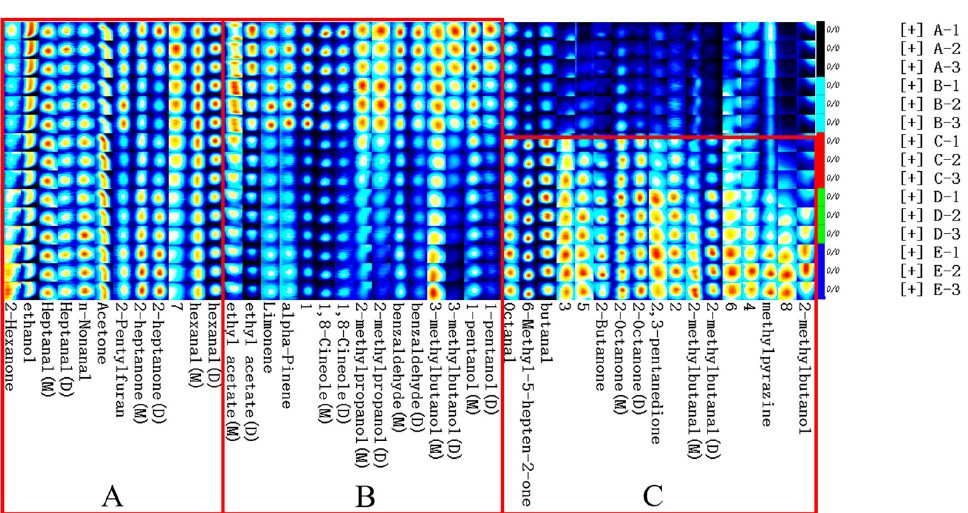
Figure 5. Fingerprint of volatile organic compounds in tilapia fish cakes with different treatment methods. Numbers represent unidentified components. M and D in the parentheses represent the monomer and dimer of the substance, respectively.